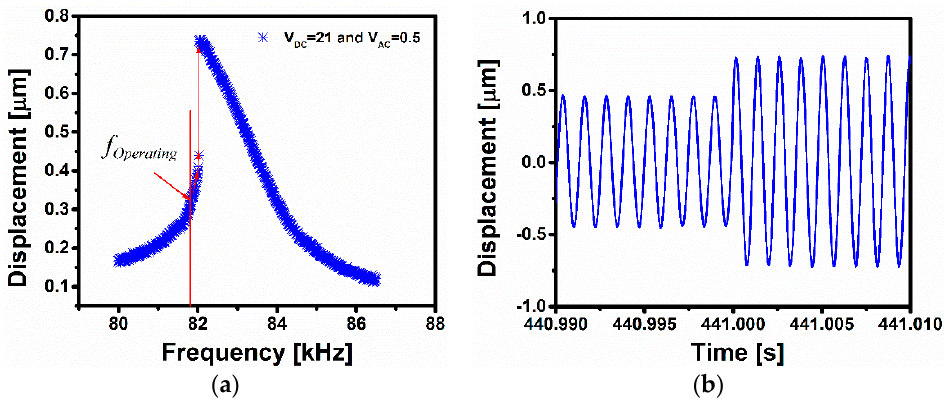
Figure 5. ( a ) Frequency response for the Jump-up switch indicating in the vertical red line the operating point of the device prior to mass detection. The red line highlights the jump in the response from the lower to the upper branches, which occurs upon mass detection when exceeding a certain threshold; ( b ) Time history of the beam displacement upon gas exposure showing the jump from the lower to the upper dynamical states, thereby triggering the switching event.